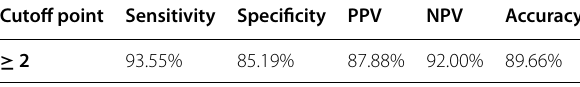
Table 7 Prediction of adverse pregnancy outcomes in lupus patients using a risk score